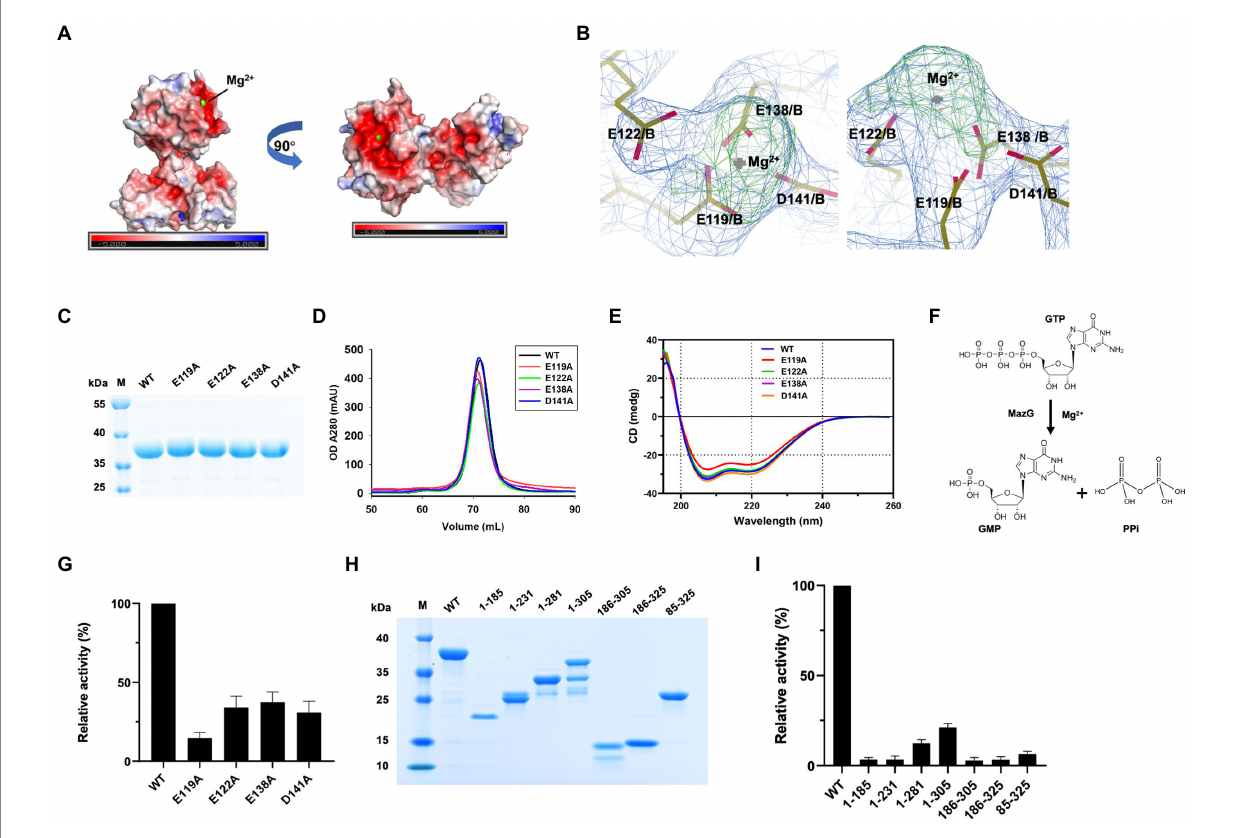
FIGURE 4 The magnesium binding sites and enzymatic characterizations of Mtb-MazG. (A) The surface potential charge of MazG (1–185) structure. Red: negative charge; blue: positive charge. (B) The electron density map (2Fo-Fc, level = 1.0) of magnesium-bound residues in MazG. (C) SDS-PAGE of MazG and different mutants. (D) The gel filtration profiles of MazG and different mutants. (E) CD spectra of MazG and its mutants measured at 18 ° C. Each spectrum reported here is an average of three scans. (F) Schematic diagram of the enzymatic reaction. MazG hydrolyzes GTP into GMP and pyrophosphoric acid. (G) The relative activities of WT and different mutants of Mtb-MazG. The activity of WT was taken as 100%. (H) SDS-PAGE of WT MazG and its various truncations. Notably, MazG (1–281), MazG (1–305), and MazG (186–305) showed degradation during the purification process. (I) The relative activities of WT MazG and different truncations. The activity of WT was taken as